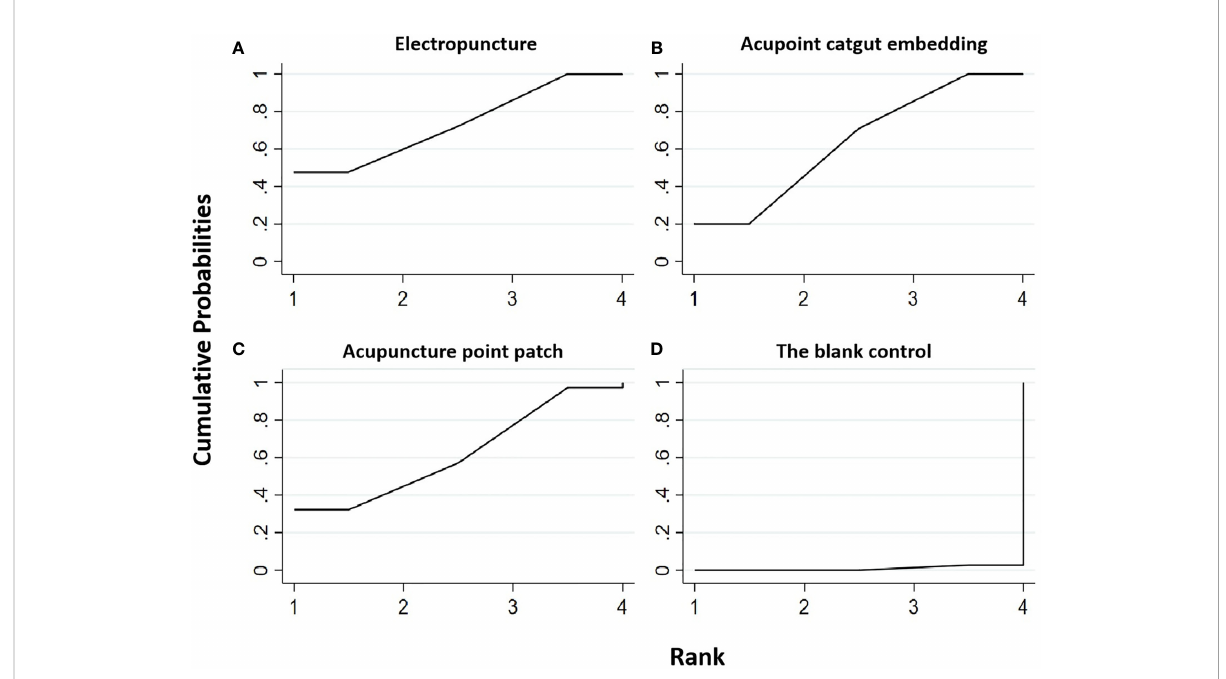
FIGURE 7 Ef fi cacy ranking and cumulative probability graph of waistline treated by different types of intervention. Comparison of ef fi cacy ranking and cumulative probability of waistline between each kind of intervention. (A) Electropuncture, (B) acupoint catgut embedding, (C) acupuncture point patch, and (D) blank